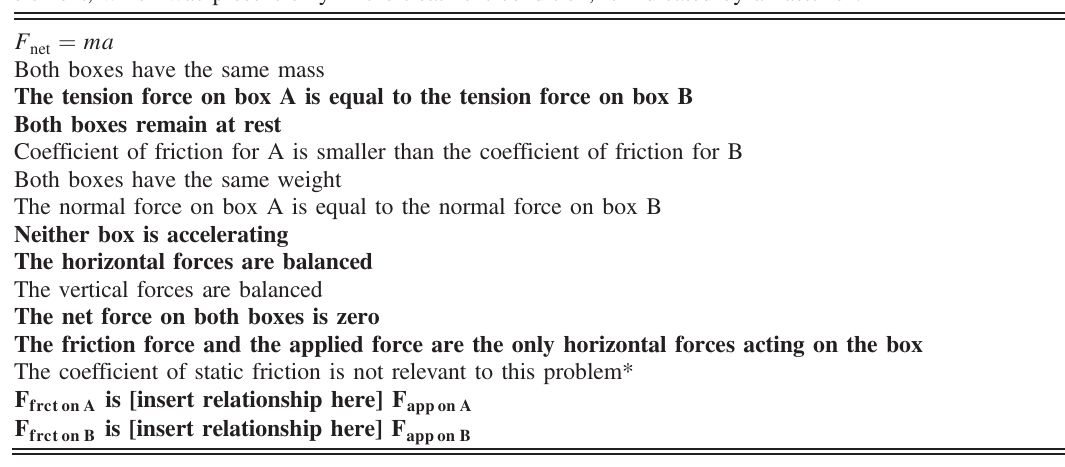
TABLE VI. Reasoning elements provided to the students on the chaining version of the two-box friction task [see Fig. 2(b)]. Elements productive to the correct line of reasoning are bolded. The final two elements had a text box in which students could indicate whether the friction force was greater than , less than , or equal to the applied force for each box, and students were given special instructions on how to use these text boxes. The analytic intervention element, which was present only in the treatment condition, is indicated by an